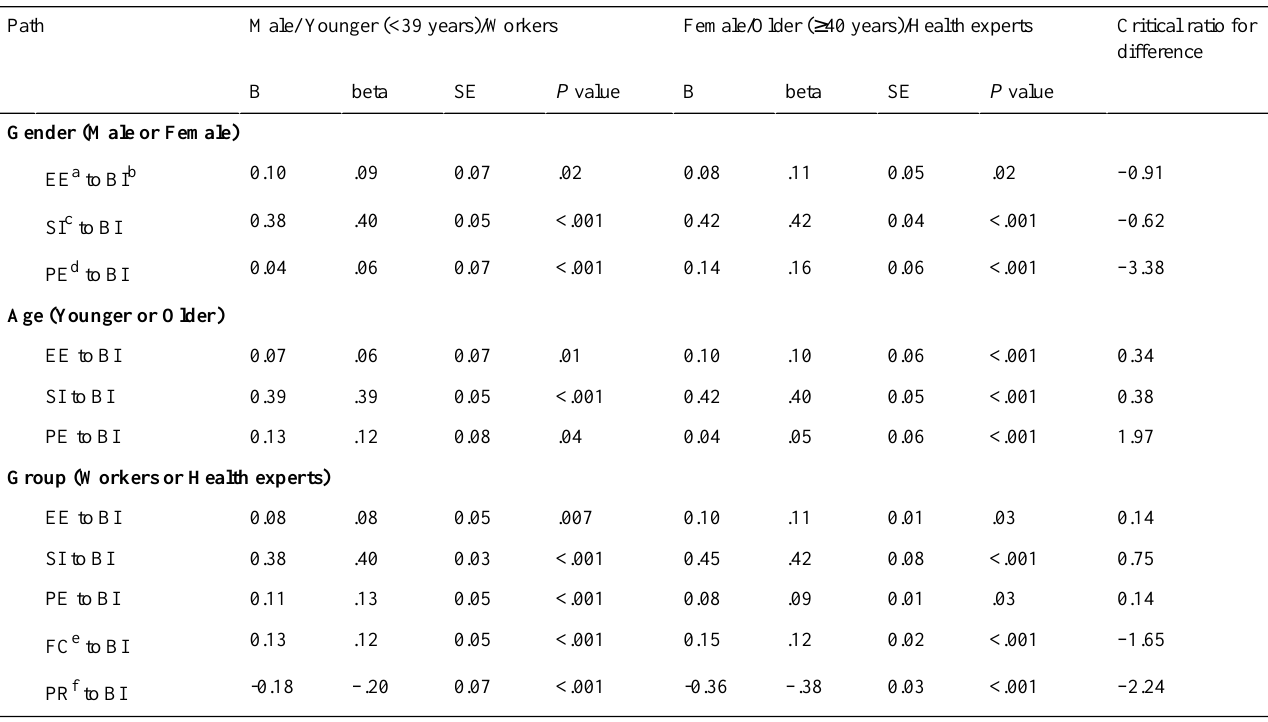
Table 9. Multigroup path analysis.